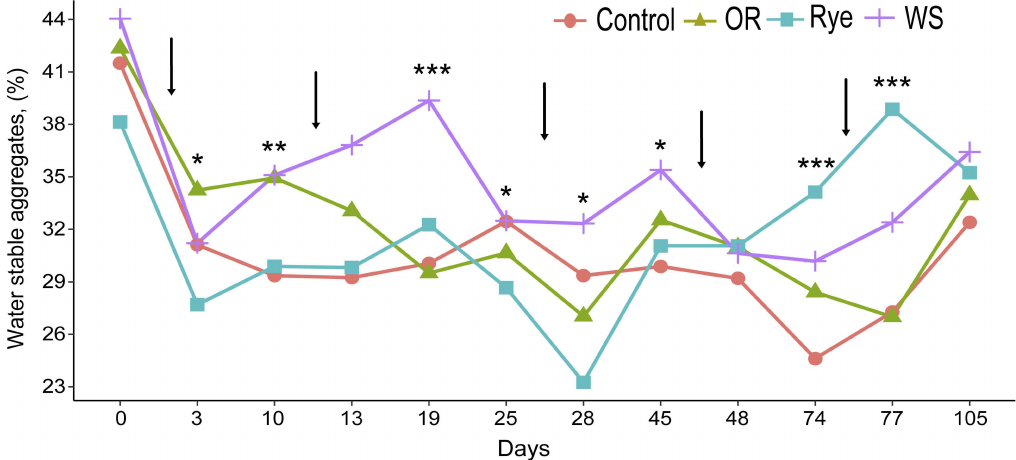
Figure 2. The evolution of water-stable aggregates in each of four treatment conditions over a 105-day incubation period: soil only (Control), soil mixed with oilseed rape residues (OR), soil mixed with rye residues (Rye), and soil mixed with wheat straw (WS). Arrows indicate the water addition events. Stars indicate significant di ff erences between treatments within the same day according to one-way ANOVA (* p < 0.05, ** p < 0.01, and *** p <